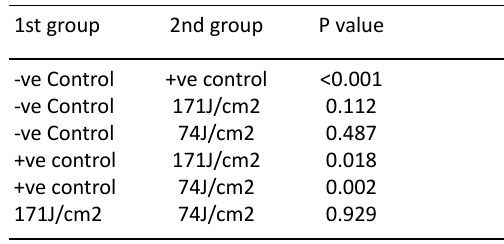
Table 10. Head circumferences comparison in day two between every pairs 1st group